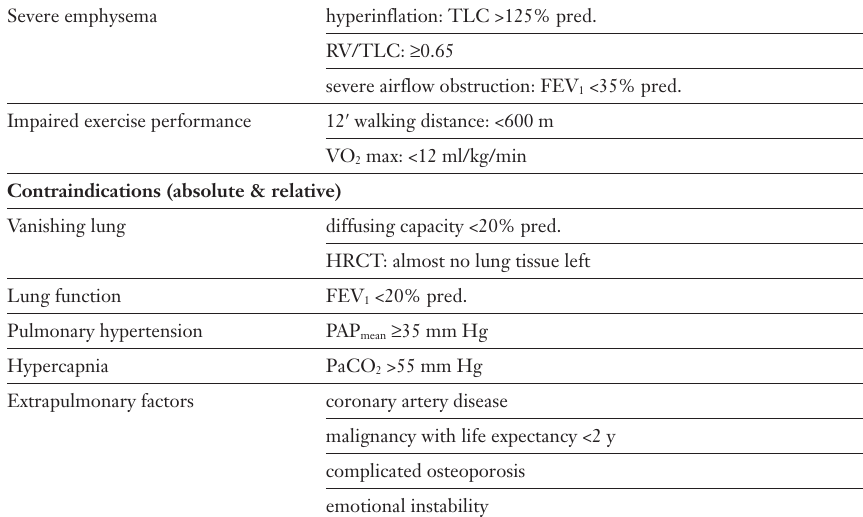
Patient selection for